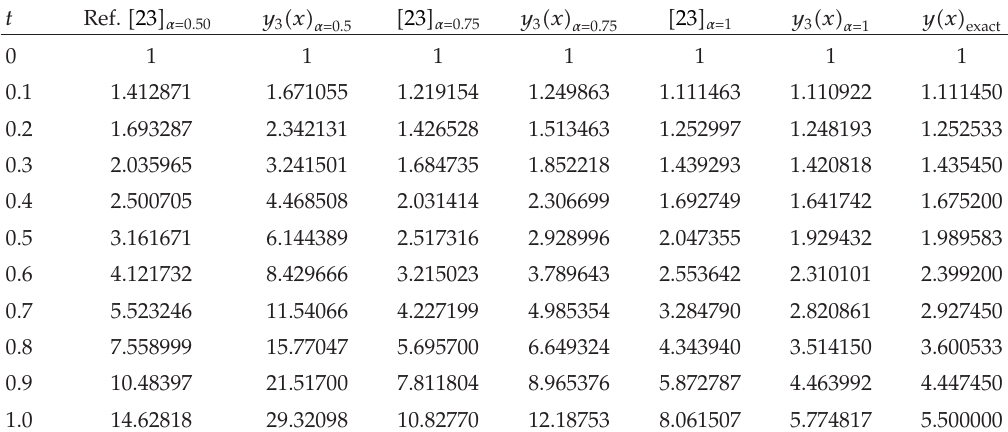
Table 3: Approximate solutions for (cid:3) 4.21 (cid:4)